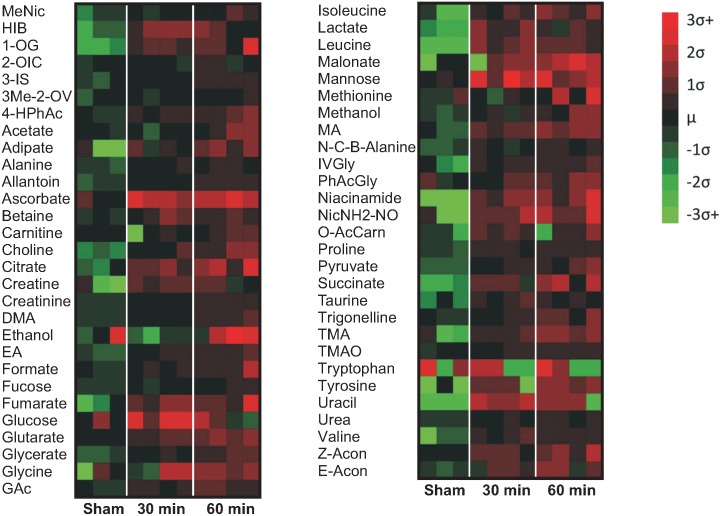
Heat map profile of metabolites from sham and acute intestinal ischemia/reperfusion (AII/R) animals.There were 57 compounds that were identified in the urine of mice in the sham and AII/R-treated groups. These metabolites belong to a variety of biochemical sub-groups. Metabolite concentrations across all animals were averaged and the resulting difference (± standard deviation; σ) displayed as a color index of red (>mean) or green (<mean). Sham (#1–3), 30 min (#4–7) and 60 min (#8–11) intestinal ischemia animals.